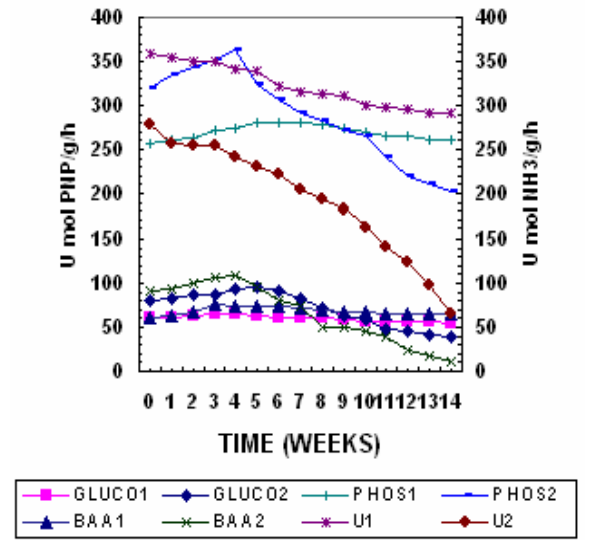
Fig 6: Activities of various enzymes during